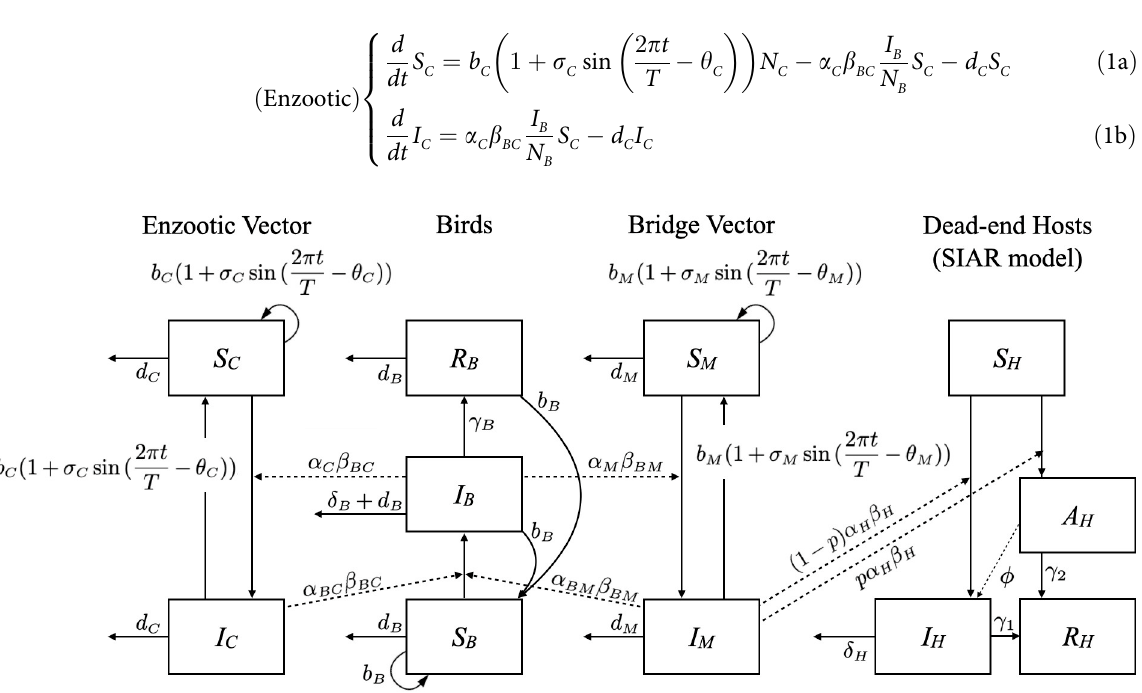
Fig 2. Schematic of the EEE transmission model with seasonal forcing.